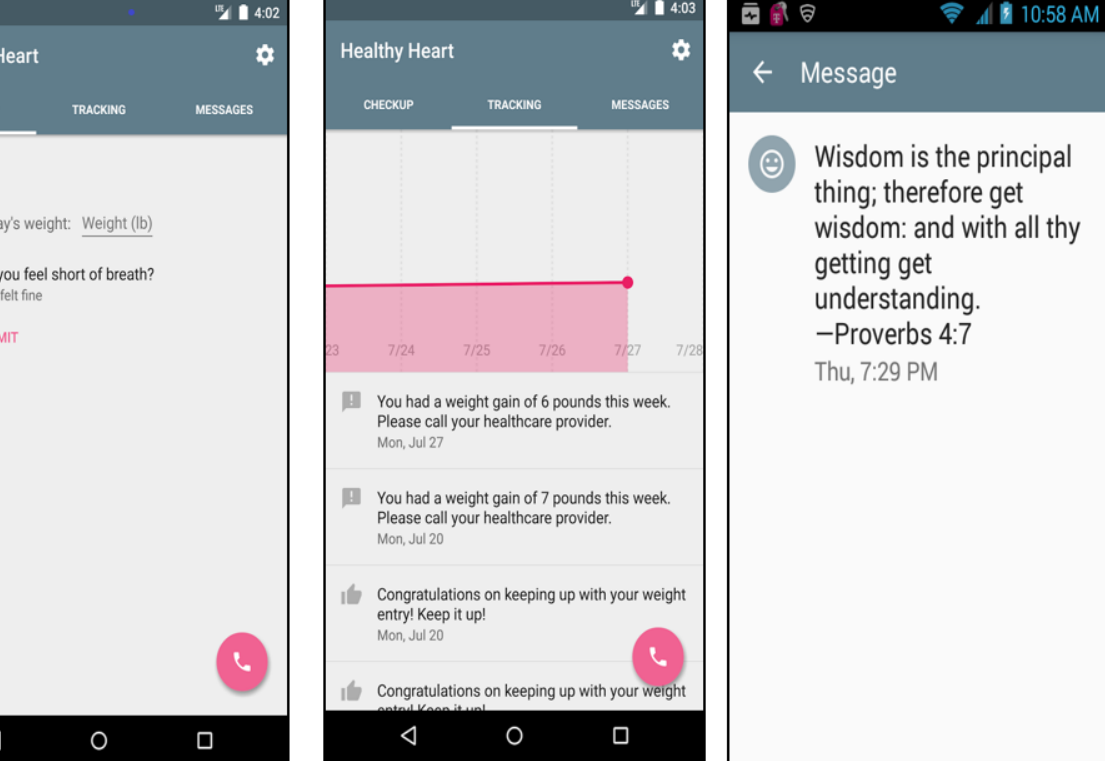
Figure 1. Screenshots of sample app